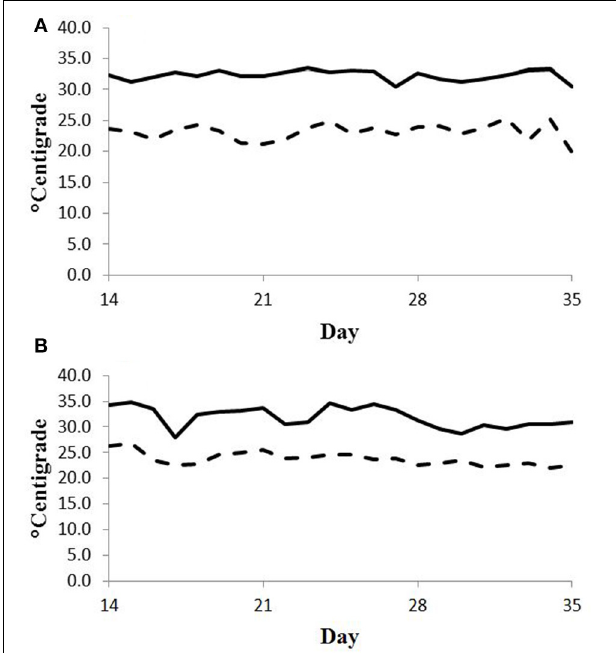
FIGURE 3 | Daily minimum (dashed line) and maximum (solid line) temperature ( ◦ C) during days 14–35 of period 1 (A) and period 2 (B) in Experiment 2. Day 21 was the first day of seed feeding in each